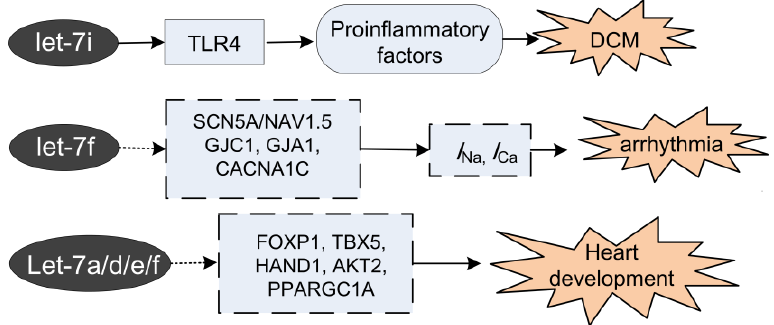
Figure 2. Targets of let-7 in dilated cardiomyopathy (DCM), arrhythmia and heart development. The solid arrow indicates the confirmed targets and the dotted arrow indicates the predicted targets of